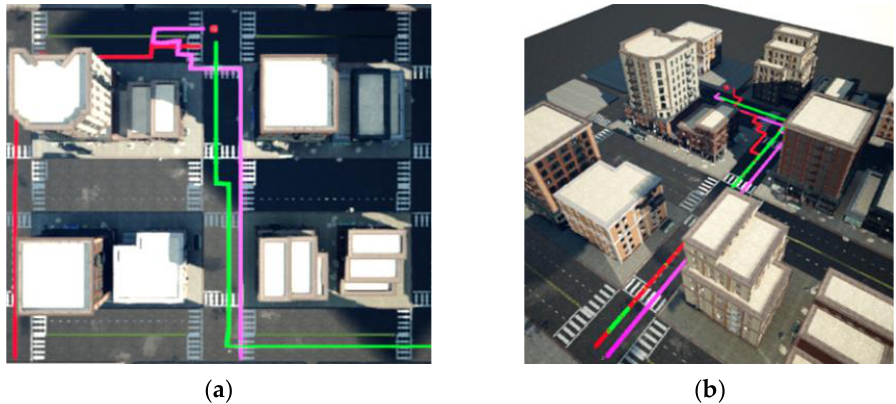
Figure 11. Path-planning results obtained by C51-Duel-IP algorithm: ( a ) is the results of scenario 1; ( b ) is the results of scenario 2.